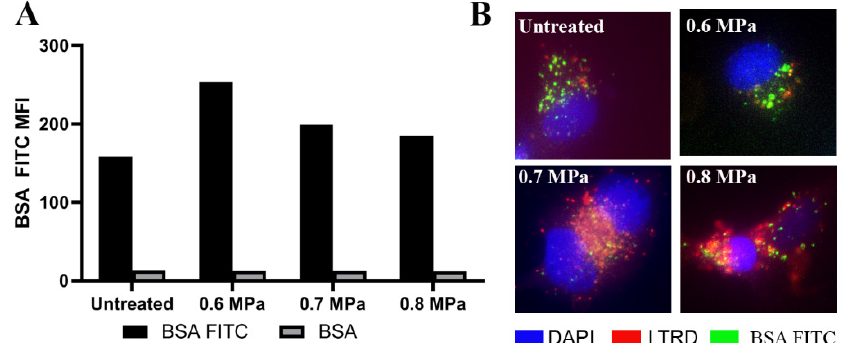
Figure 2. HUVECs loaded with bovine serum albumin conjugated with fluorescein isothiocyanate (BSA FITC) before and after USMB application at different acoustic pressures. After administering BSA FITC with USMB, HUVECs were incubated for 1 h and then, the medium was refreshed. After 2 h, HUVECs were harvested and measured with flow cytometry to quantify the BSA FITC signal, depicted as MFI ( A ). The results presented were the mean of two independent experiments. These cells were also stained with a nuclear stain, DAPI (blue) and a lysosomal marker, LTRD ( B ). Co-localisation of red and green colours indicate the presence of BSA FITC in the lysosomal compartment ( B ). These images were representative images taken at 60× magnification using a fluorescence microscope (Keyence BZ9000, Mechelen, Belgium).